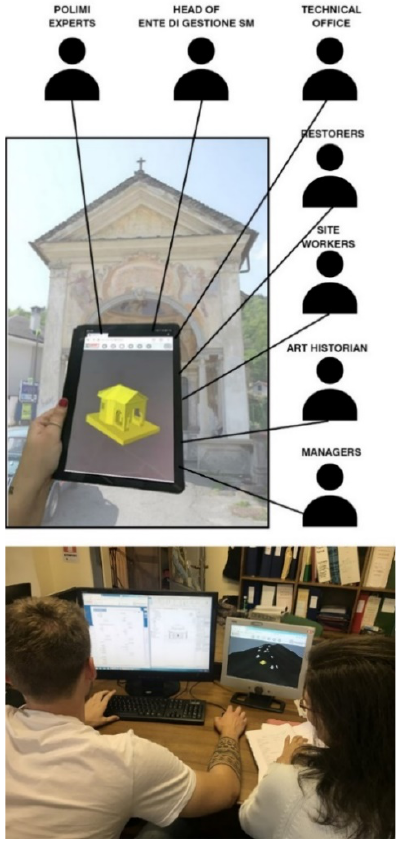
Figure 4. BIM3DSG connects experts’ users with different backgrounds and gives the possibility to manage the models and information without the need for particular skills and